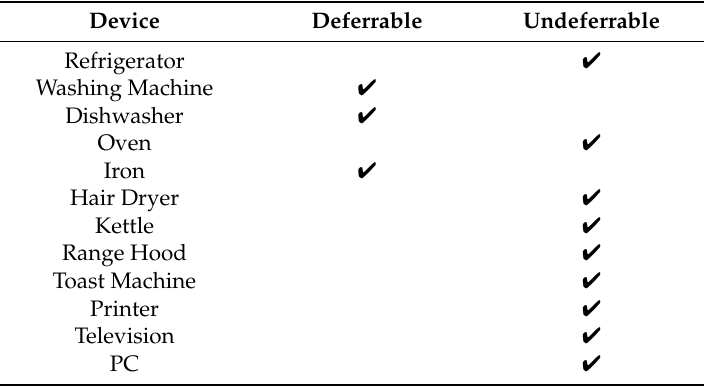
Table 6. The classification of home